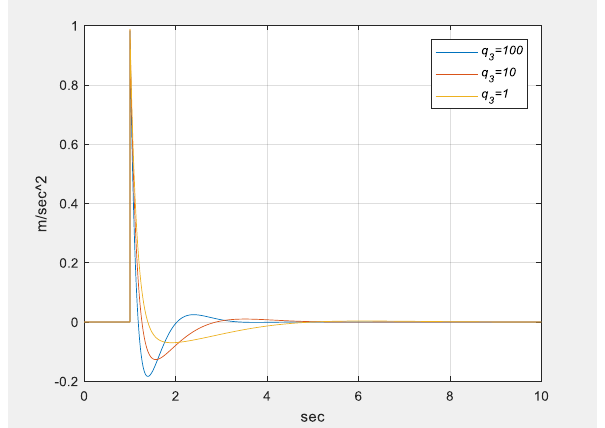
= 100, and β = 1  = . Figure 23. Influence of q 1 1